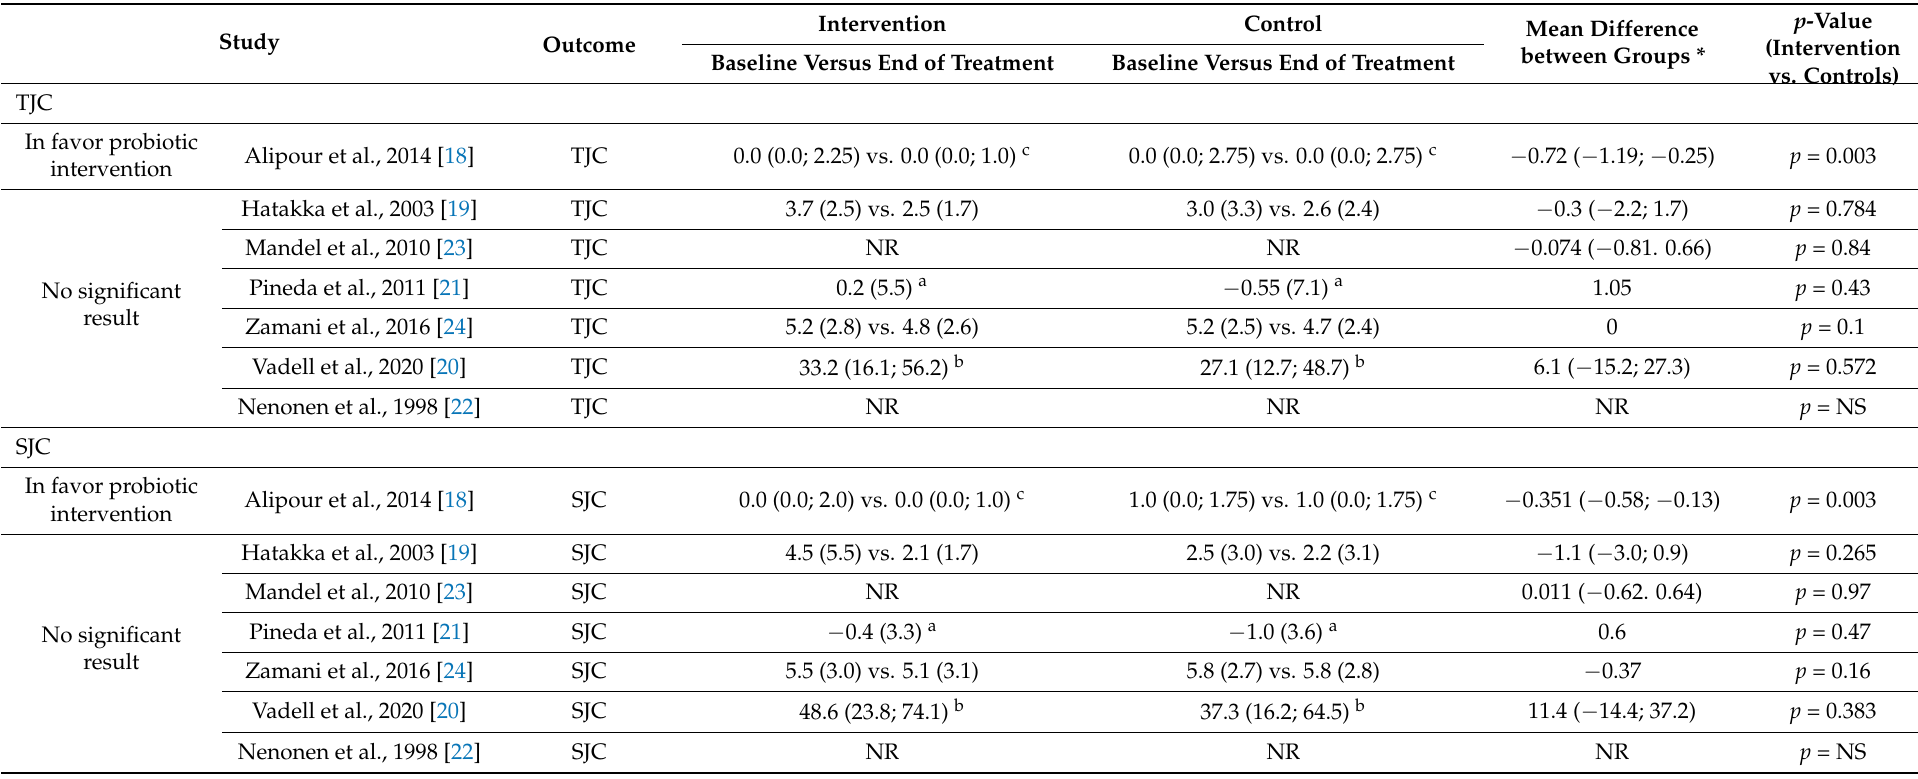
Mean Difference between Groups *